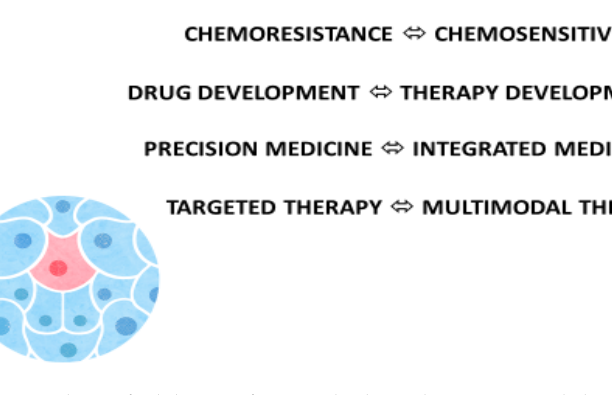
Figure 2. Stem cell origin and a unified theory of cancer: biological processes and clinical implications. Illustration by Benjamin Tu.